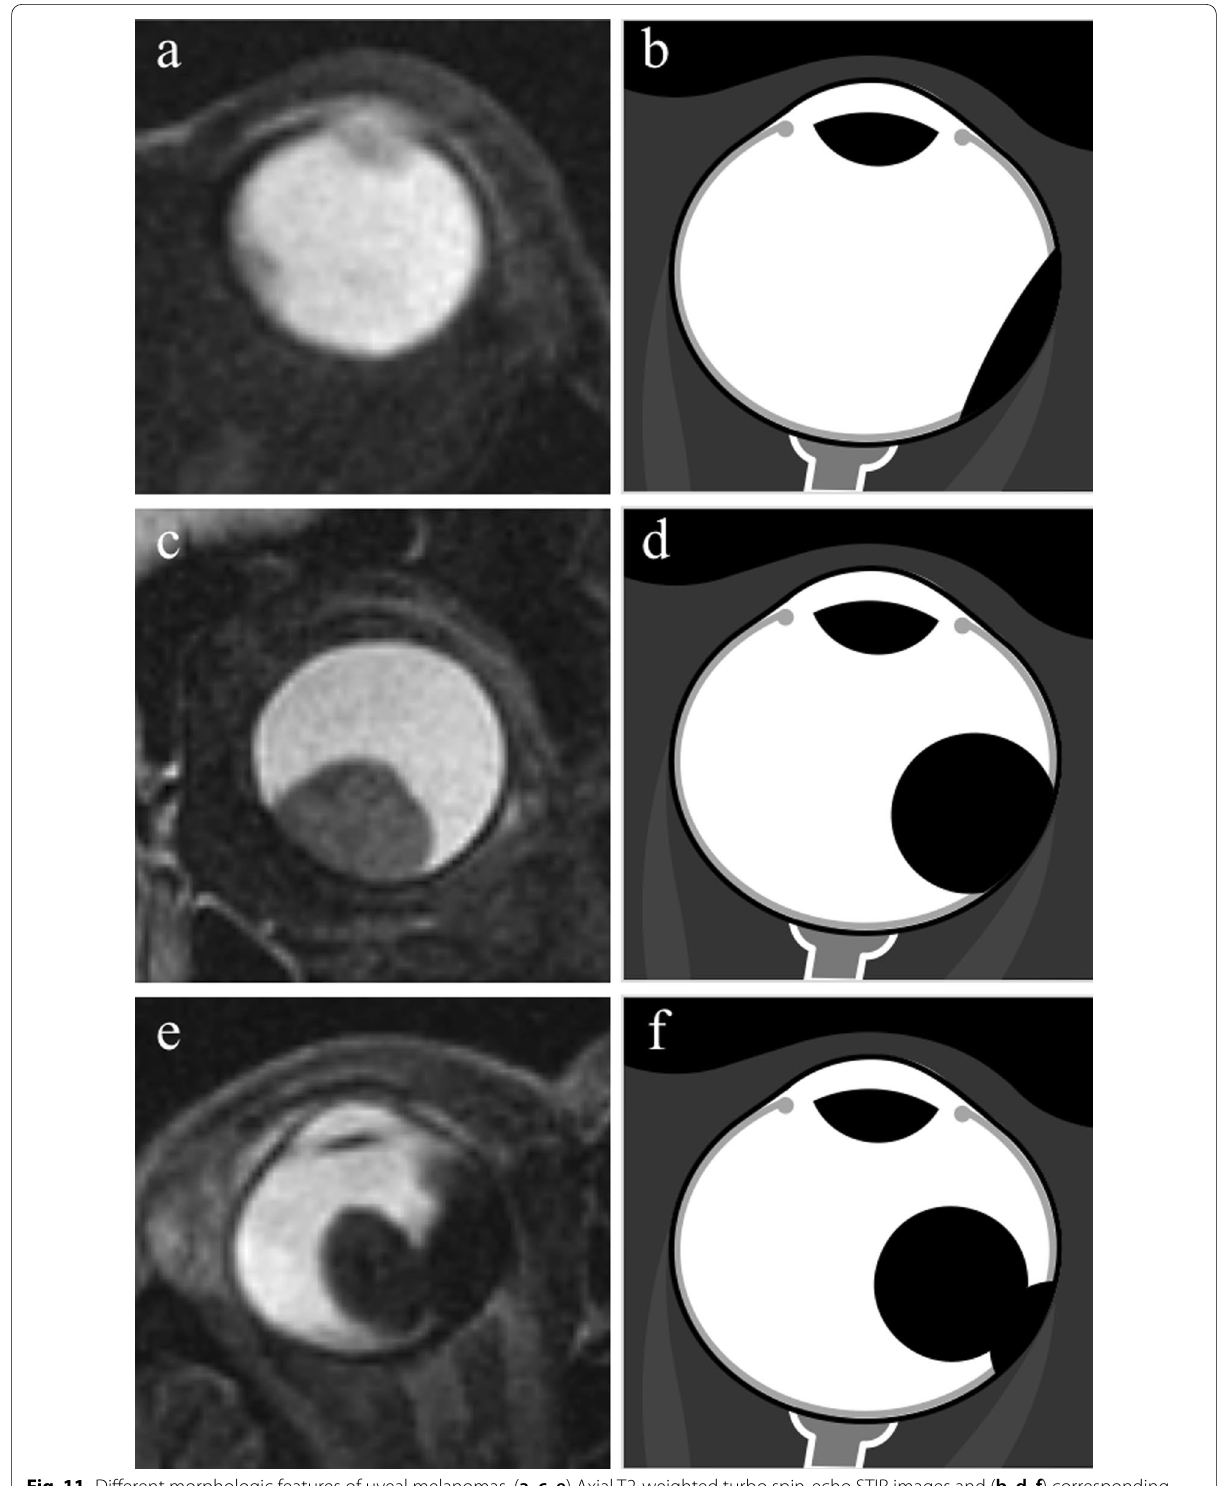
Fig. 11 Different morphologic features of uveal melanomas. ( a, c, e ) Axial T2-weighted turbo spin-echo STIR images and ( b, d, f ) corresponding schematic drawings illustrate the three different macroscopic appearances of uveal melanomas: ( a, b ) lentiform shape or flat tumor, ( c, d ) mound or dome shape, ( e, f ) mushroom or collar-button